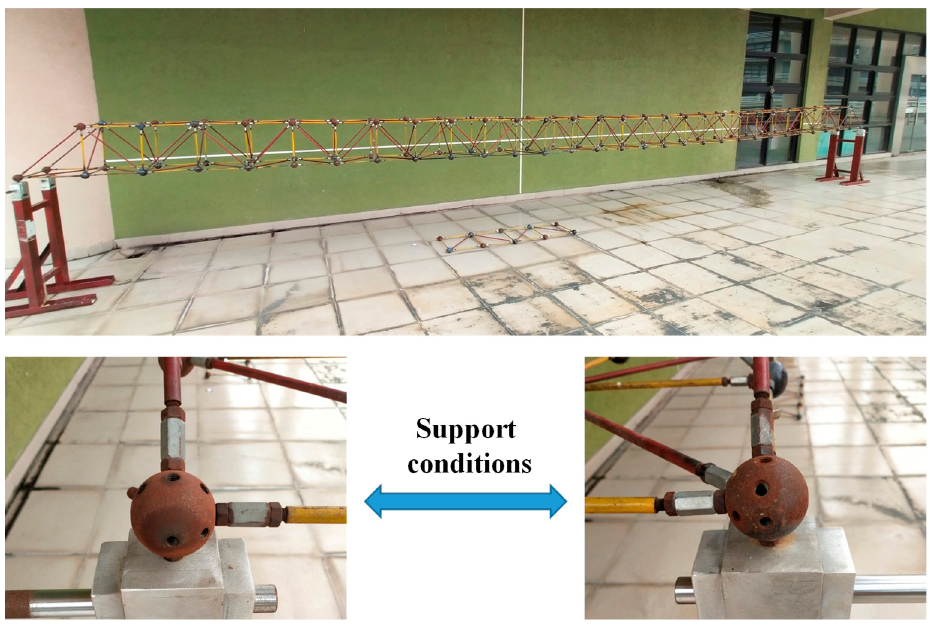
Figure 1. The steel frame modal with 381 rods.